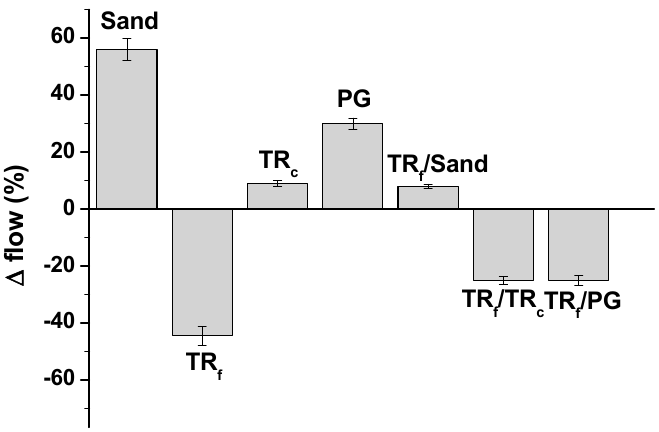
Figure 2. Flow-test results with respect to the normalized mortar (norm sample).